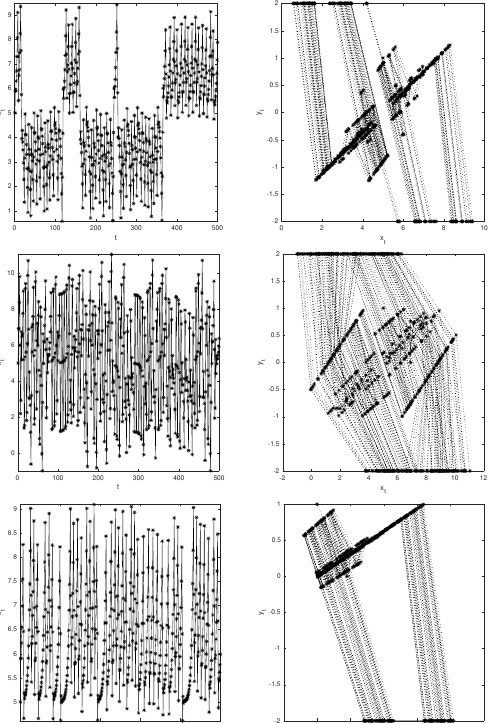
Figure 6. The ( top-left ) shows the price evolution and ( top-right ) the phase space of the fundamental map dynamics with a = 1, b = 0.7 and c = 1.5, note that 1 right ) show the price evolution and the phase space of fundamental map dynamics with a = 1, b = 0.9 and c = 3.4.